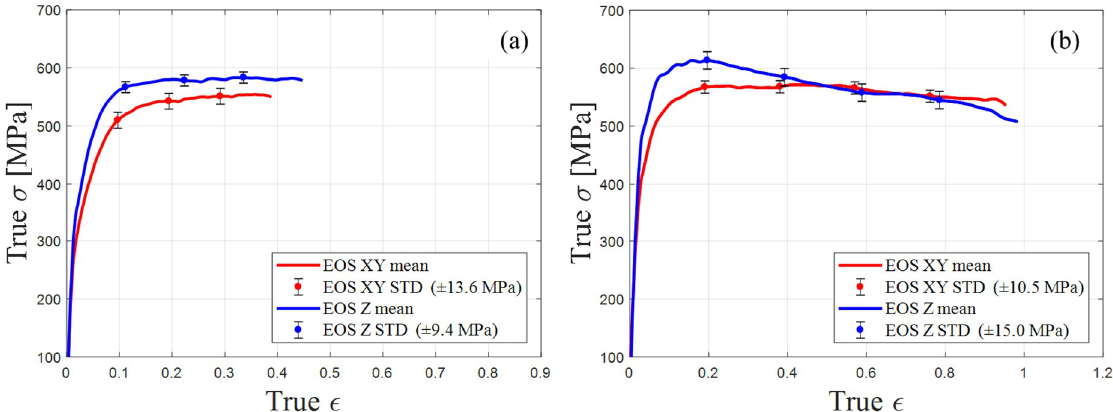
Figure 9. EOS samples mean value and standard deviation (STD) of true stress–true strain curves: ( a ) Comparison between XY- and Z-oriented samples at true strain rate ranged of 700 to 2800 s −1 ; ( b ) comparison between XY- and Z-oriented samples at true strain rate ranged of 4000 to 6700 s −1 .